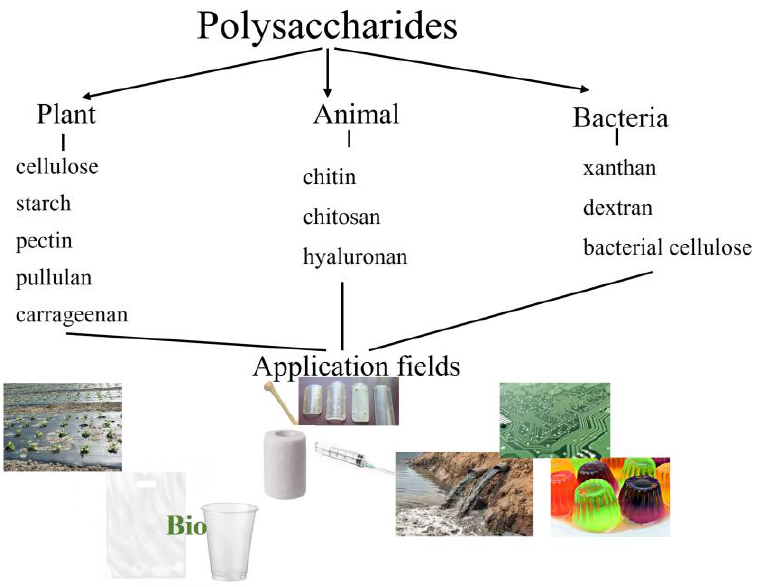
Scheme 1. Main sources of polysaccharides with examples and some application Table 1. Advantages/disadvantages of polysaccharides as component of biodegradable material.